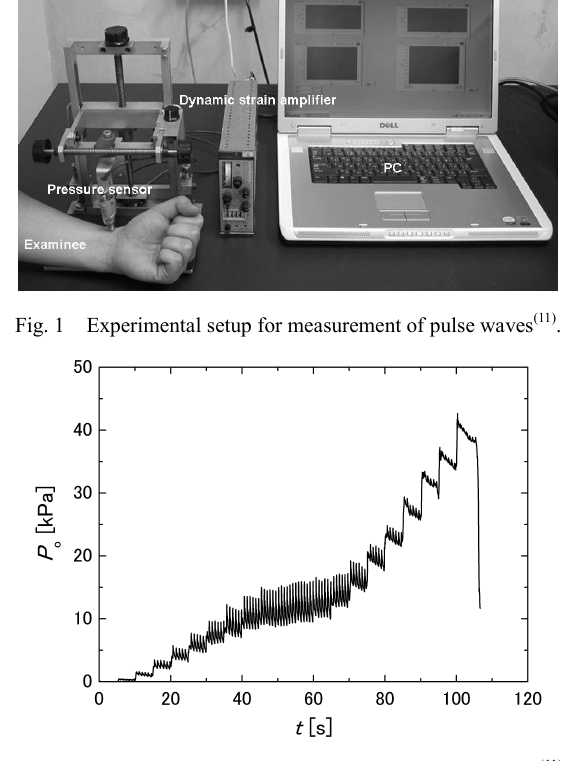
Fig. 2 Measured pressure waves P o during the indentation (11)